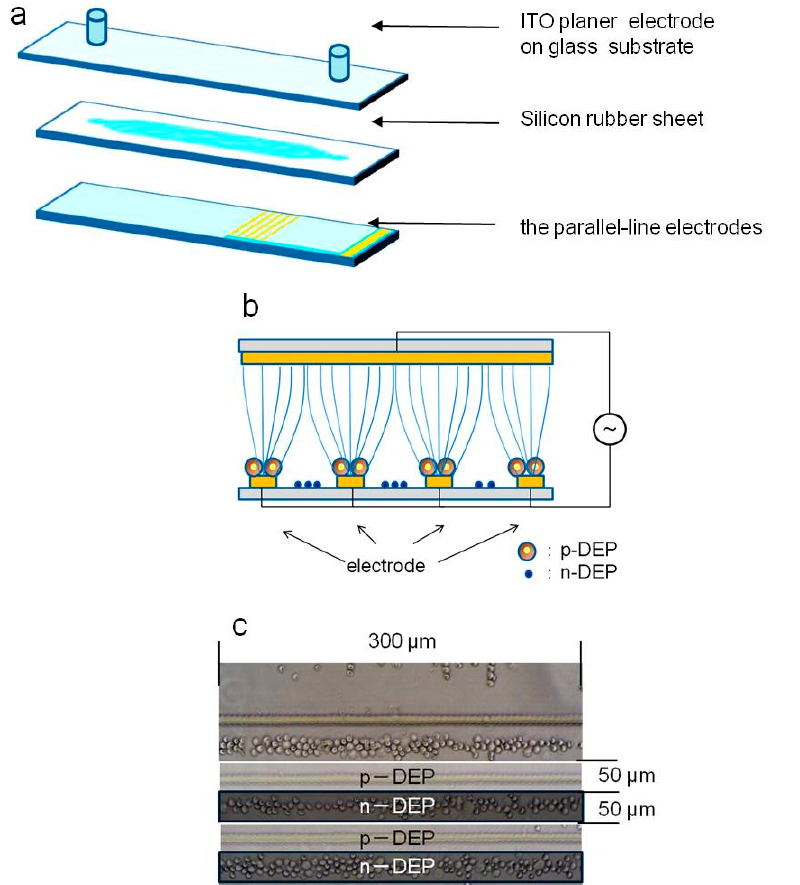
Figure 1. Dielectrophoretic characterization of living cells: ( a ) Schematic of dielectrophoresis (DEP) chamber; ( b ) Positive- and negative- DEP of living cells; ( c ) Discrimination of positive- and negative- DEP.